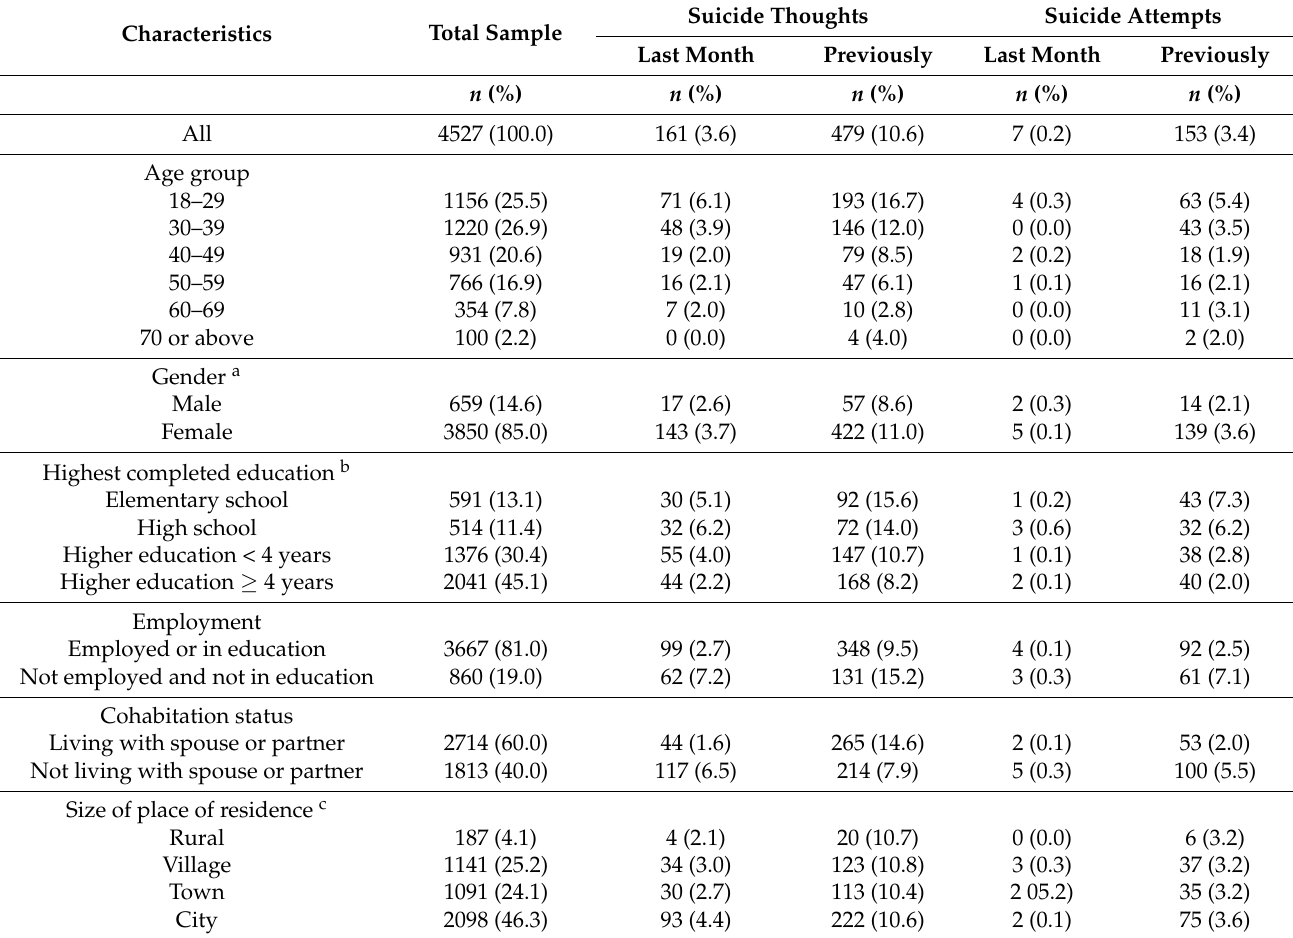
Table 1. Sociodemographic characteristics of the sample, and suicide thoughts and suicide attempts in sample subgroups.